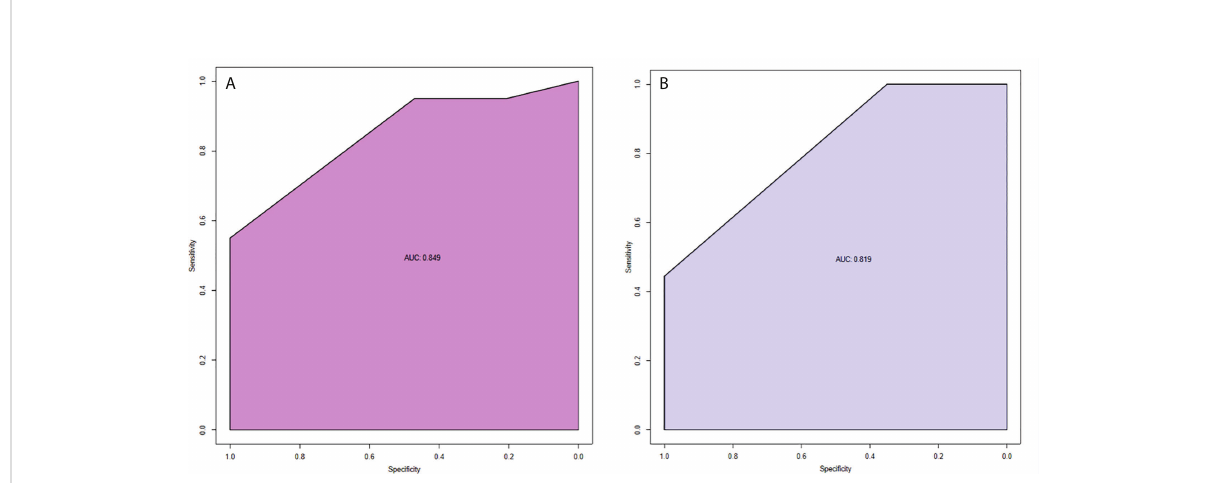
FIGURE 3 ROC curves of nomogram in the training set (A) and validation set (B) . AUC of the predictive model was 0.849 (95% CI = 0.750 − 0.949). AUC of the model of the validation set was 0.819 (95% CI = 0.693 −